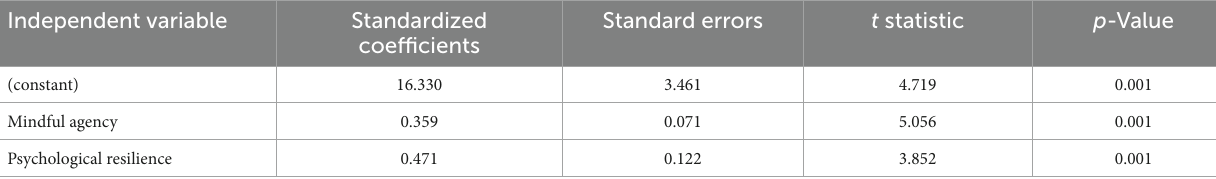
TABLE 3 Simultaneous multiple regression model results (2 independent variables enter model together). Independent